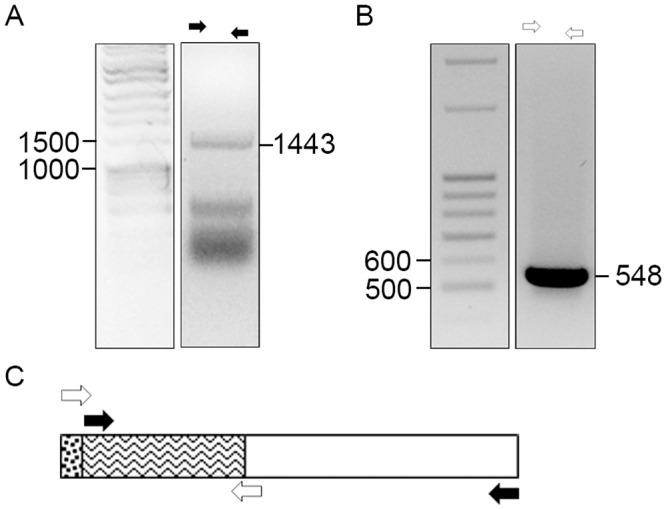
Normal human placenta tissues contain transcripts encoding Act A X2 variant.cDNA was prepared from human placenta RNA and used as template to amplify Act A transcripts by PCR. The PCR products were size fractionated on 1% agarose gels, and bands were purified and subjected to Sanger sequencing to confirm transcript identity. A, amplification of exons 6 and 7 using primers indicated by black arrows, yielded a predicted product of 1,443 bp. B, amplification of 5’ end of Act A-X2, using primers indicated by clear arrows, yielded a predicted amplicon of 548 bp. C, schematic representation of X2 variant and primer sets (White and Black arrows) used to amplify products shown in A and B. Size markers; Fisher exACTGene DNA ladder is on the left, lane 10. Also see Fig 1.